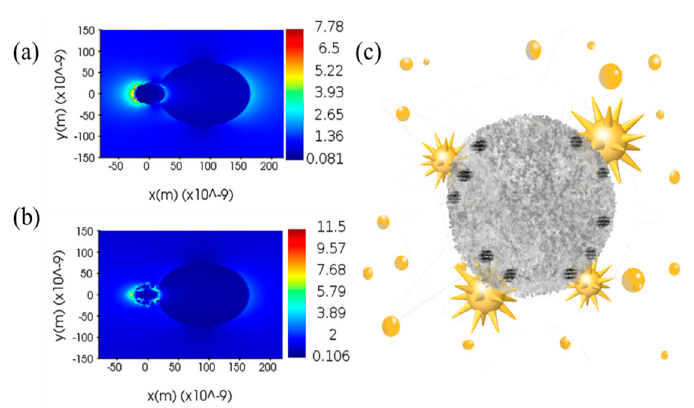
Figure 6. ( a , b ) FDTD ‐ simulated EM field amplitude distributions around the AuNPs@TiO 2 and AuNSs@TiO 2 , respectively; ( c ) Schematic diagram of AuNSs ‐ induced TiO 2 crystallization. AuNSs@TiO 2 , respectively; ( c ) Schematic diagram of AuNSs-induced TiO 2